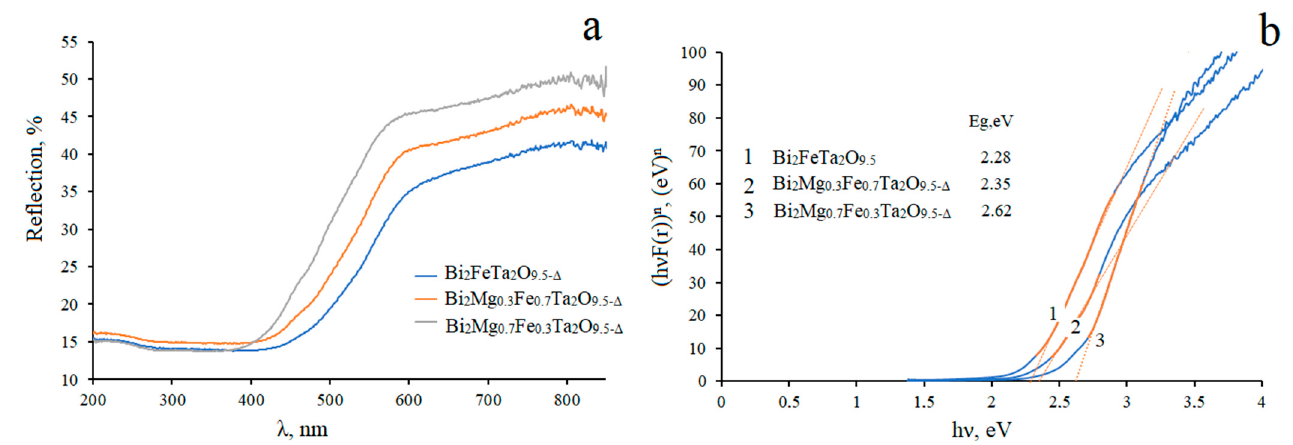
Figure 11. Diffuse reflectance spectra of the Bi 2 Mg x Fe 1-x Ta 2 O 9.5- Δ samples ( a ), Tauc curves for